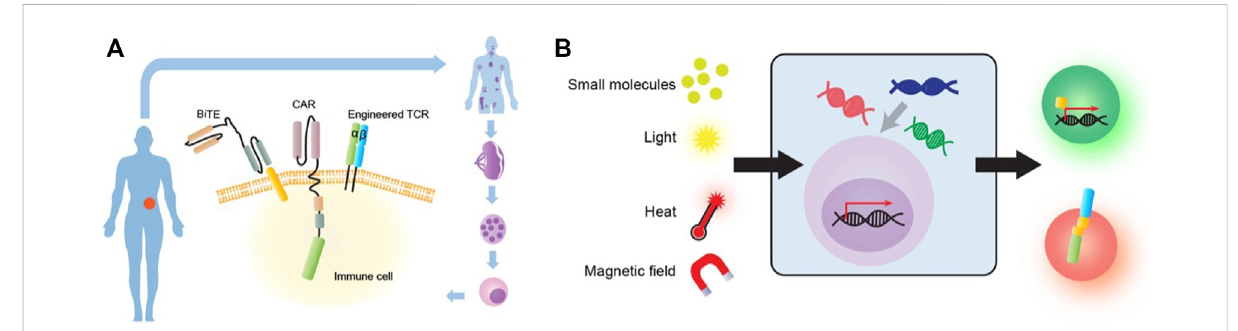
FIGURE 3 Common immuno-engineering strategies. (A) Mainstream immune-engineering strategies at cellular and molecular levels. Immune cells from patients can be engineered with different effector modalities including CAR, TCR and Bispeci fi c T cell engager (BiTE). (B) Novel biophysical or synthetic biology-based strategies to engineer immune cells for cancer therapy. The engineered immune cell can be stimulated by various input sources such as small molecules, light, heat and magnetic fi eld. These cells can then process the signal through engineered genetic circuits by transcription factor (TF) (green cell) or dimerization (red cell) to produce functional